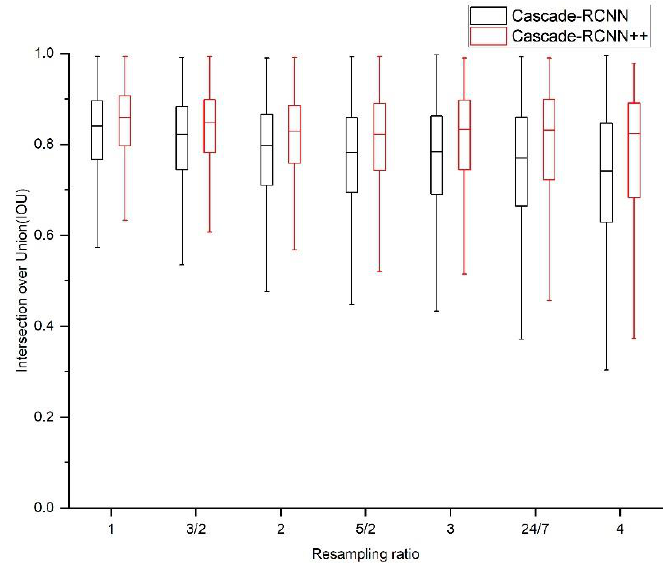
Figure 9. Boxplots of obtained IoU using Cascade R-CNN and Cascade R-CNN++ for remote sensing images upscaled by different factors.